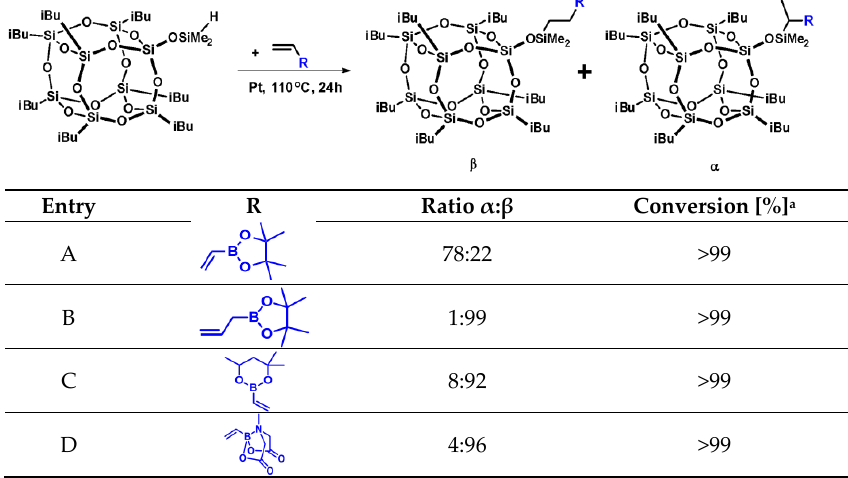
Figure 1. Selectivity and conversion of vinyl boronate hydrosilylation reactions with iBu 7 SS-H.